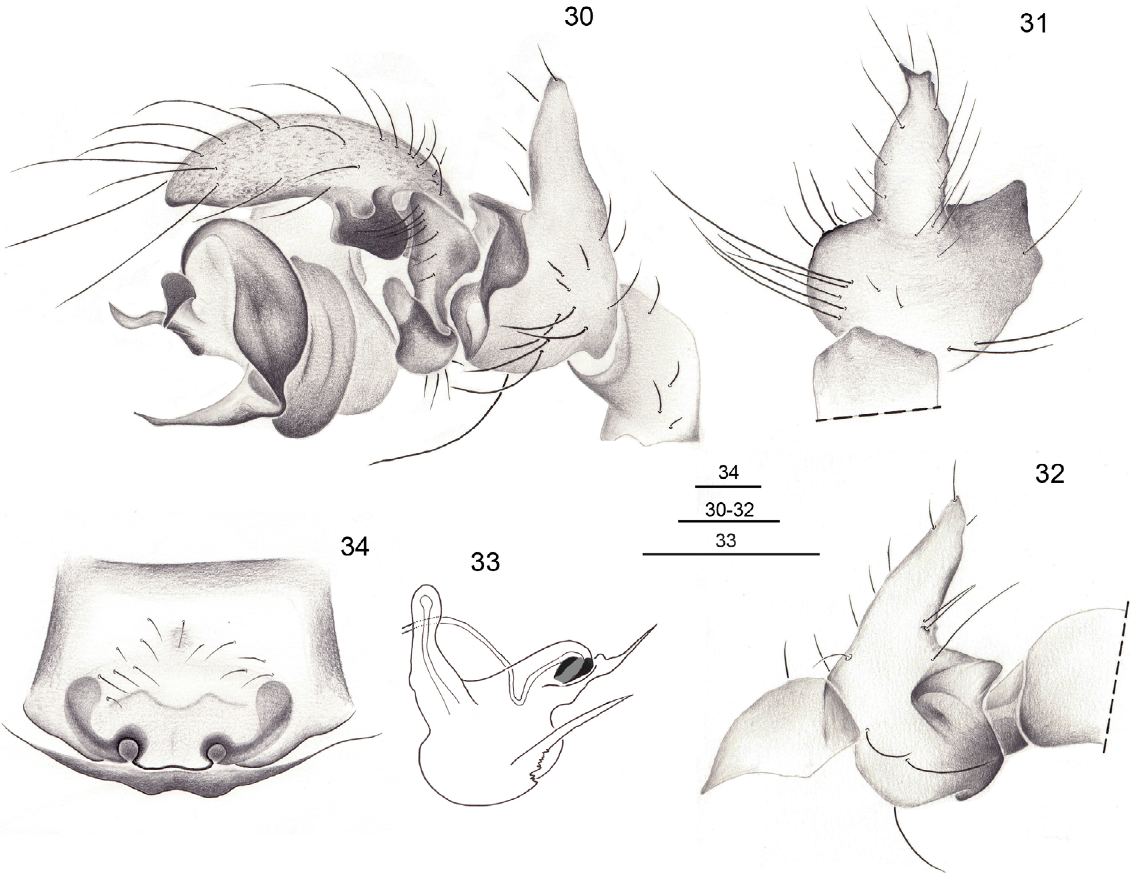
Figs 30-34. Holmelgonia bosnasutus sp. nov. (♂ holotype, ♀ paratype 227507). 30 . Palp, ♂, retrolateral view. 31 . Palpal tibia, ♂, dorsal view. 32 . Palpal tibia, ♂, prolateral view. 33 . Embolic division of ♂ palp, ventrolateral view. 34 . Epigyne, ventral view. Scale bars = 0.1